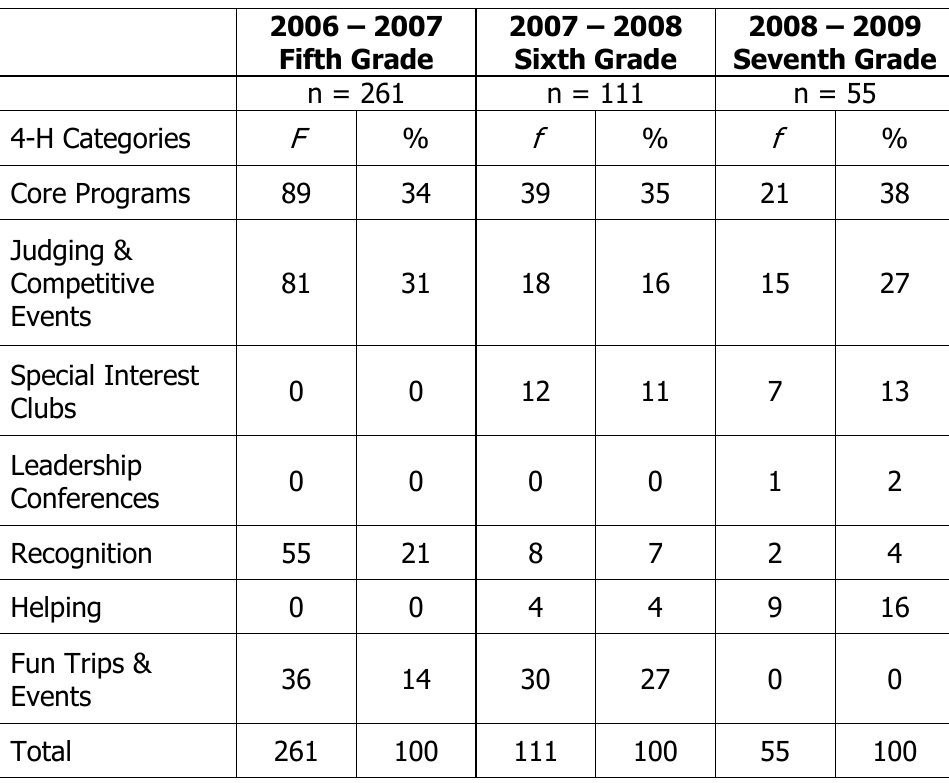
Number of 4-H Activities by Category and Year for